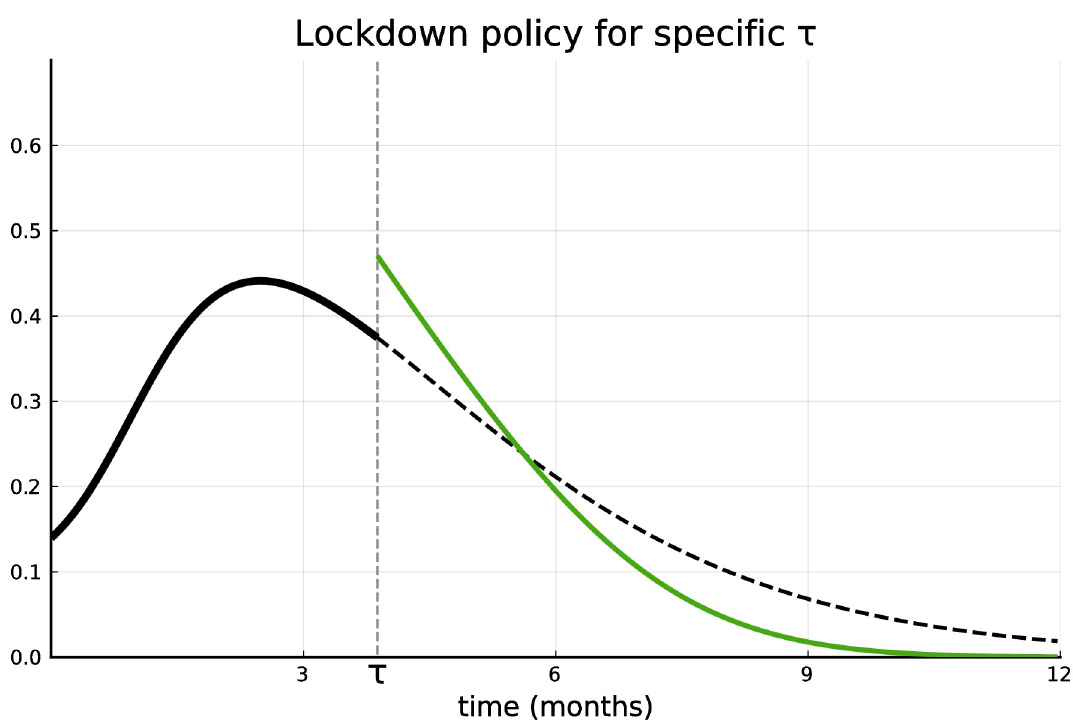
Fig 3. Lockdown intensity for approval at τ = 4. Lockdown intensity without vaccination (black line, Stage 1) and with vaccination (green line).